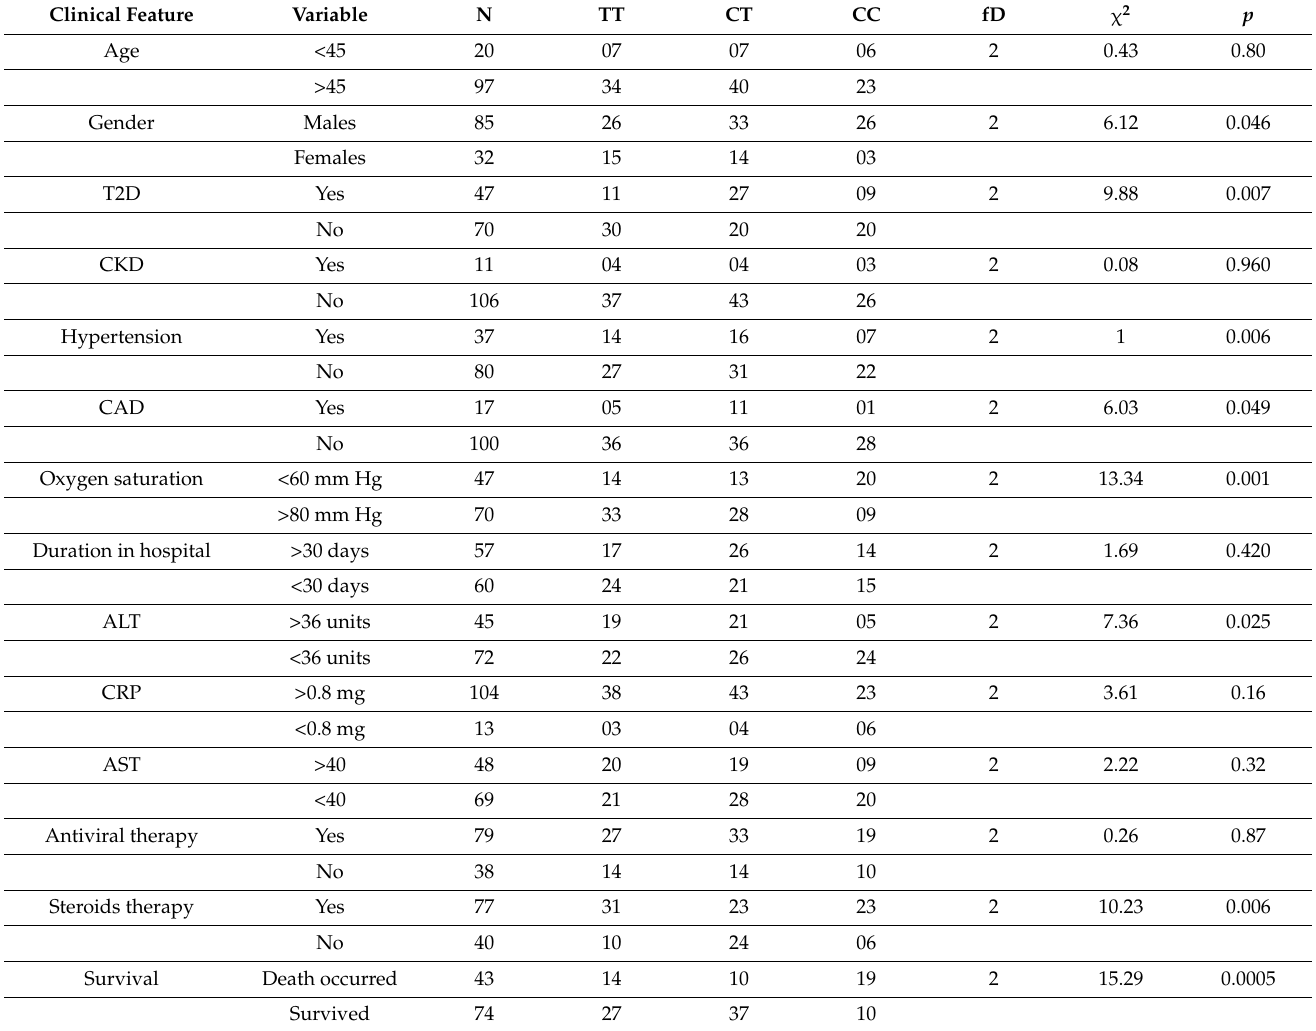
Table 10. Statistical comparisons ( p -values) of ACE2 rs4240157 T > C genotypes with comorbid conditions and some clinical parameters with COVID-19 severity. T2D—type2 diabetes; CKD—chronic kidney disease; CAD—coronary artery